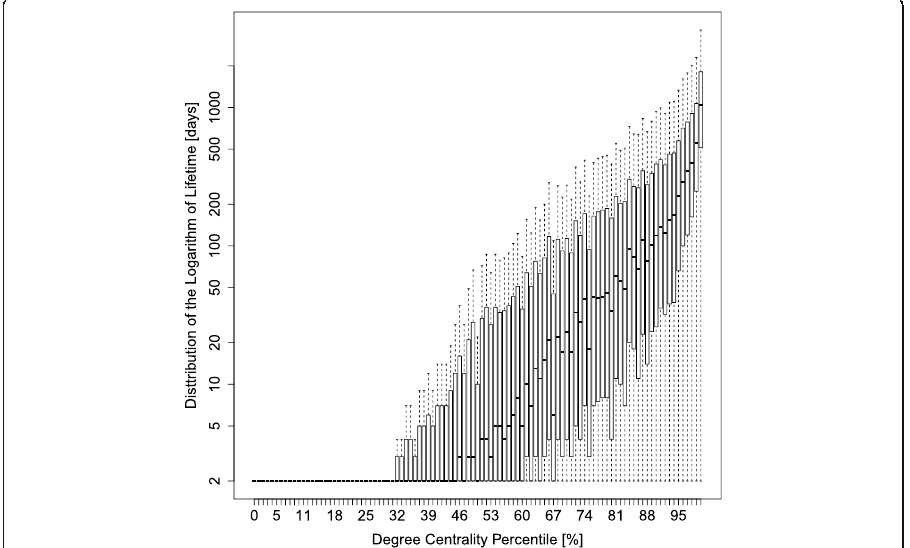
Fig. 6 Persistence in the community. A box-and-whisker plot of the distribution of user activity log-lifetime (Y-axis) per degree grouping X. The base of the log function is e here. Each equal-count centrality group is 1 %. The median lifetime is represented by thick black